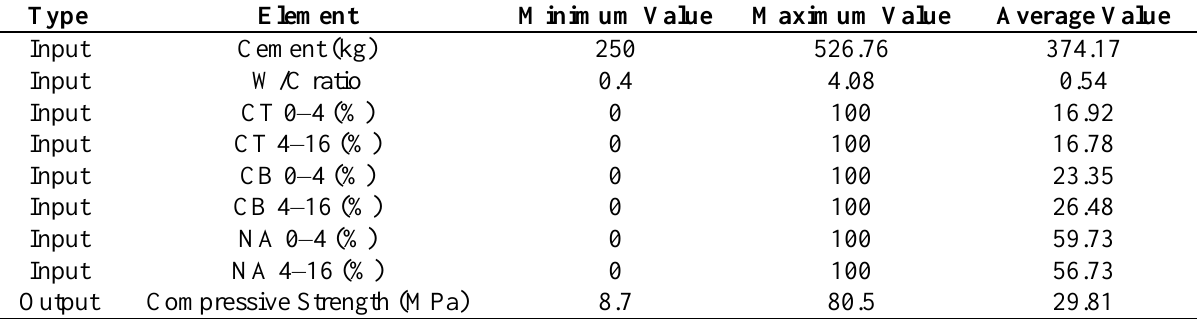
Range of Input and Output